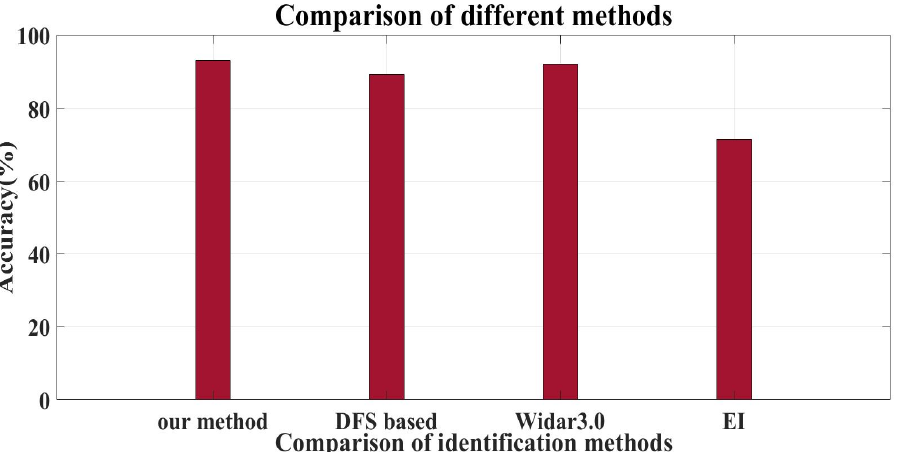
Figure 14. Comparison of recognition accuracy of different methods.